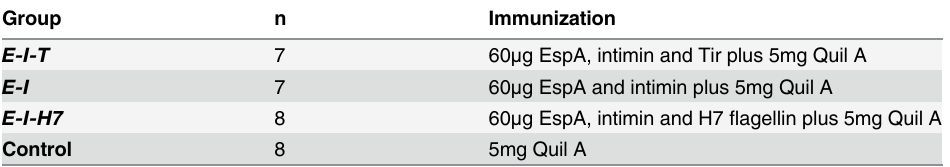
Table 1. Summary of immunization